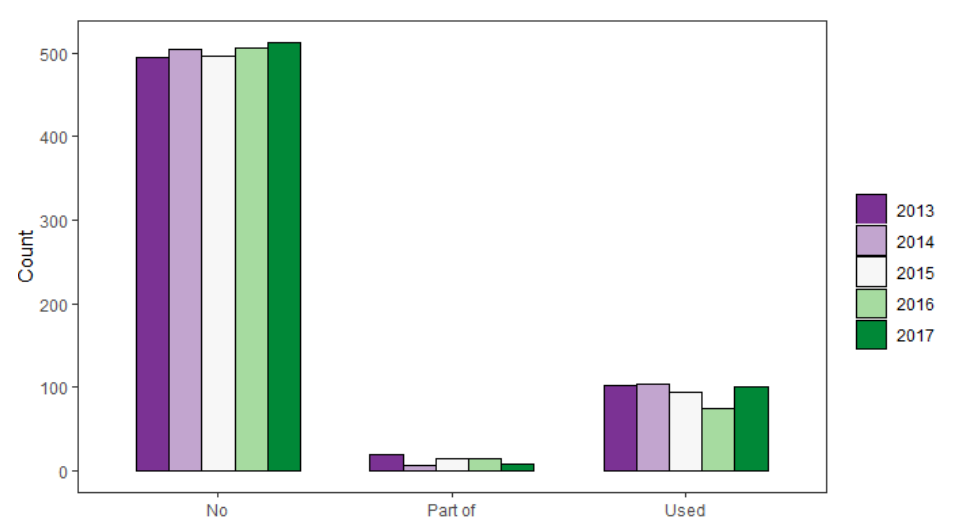
Figure 30. Deployment distribution between usage of testbed facilities and year.